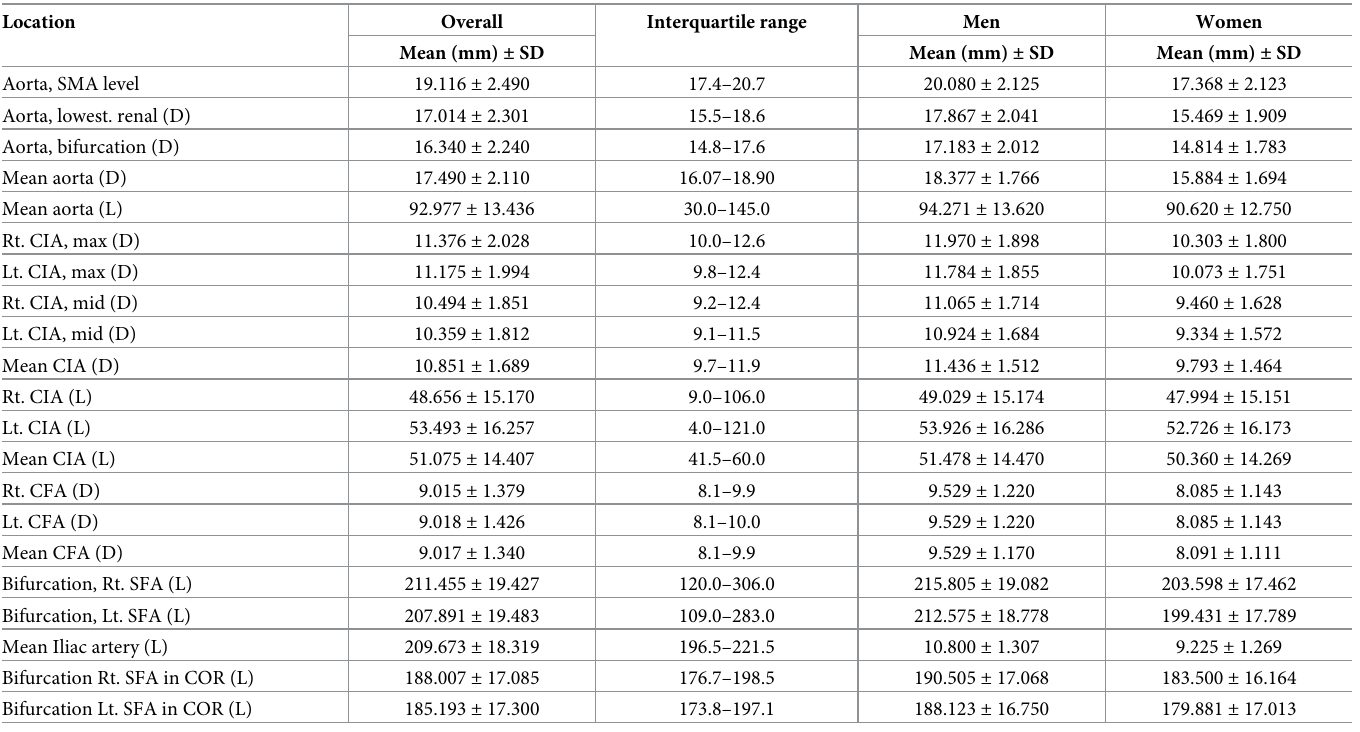
Table 2. Arterial diameters and